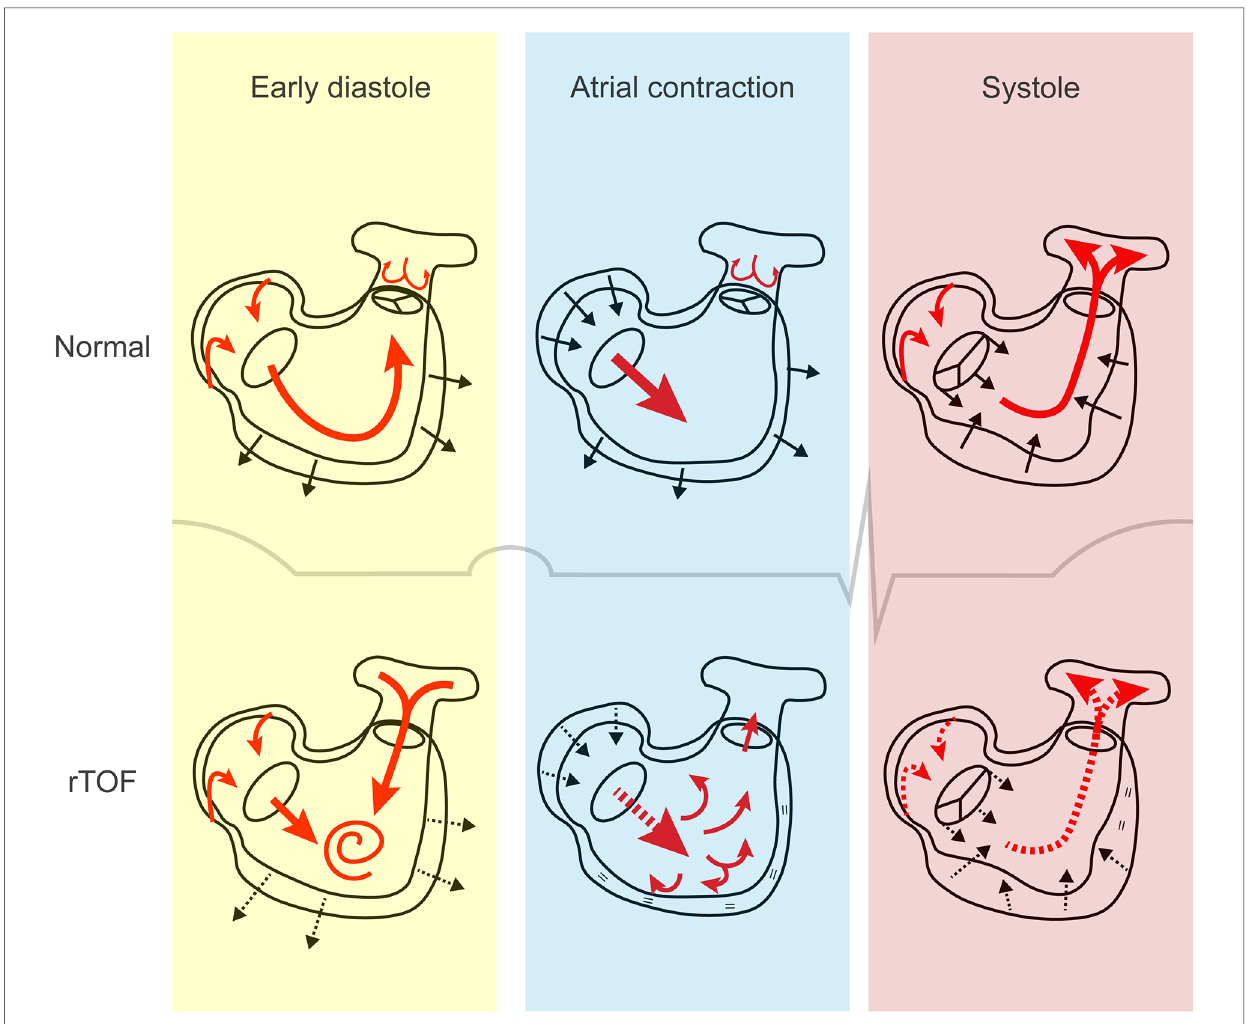
FIGURE 4 The cardiac cycle in tetralogy of Fallot. In early diastole, both right atrial conduit fl ow and pulmonary regurgitant fl ow contribute to right ventricular fi lling, resulting in increased fl ow vorticity. Decreased active relaxation and passive stiffness may be present. During atrial contraction, it is hypothesized that the stiff right ventricle may not be able to accommodate the additional blood volume, which gets displaced into the pulmonary artery. This phenomenon is referred to as end-diastolic forward fl ow. Right atrial contraction may be affected. In systole, decreased right ventricular contractility, dyssynchrony and out fl ow tract dysfunction can contribute to systolic dysfunction. Atrial reservoir fi lling is impaired if apical tricuspid movement is reduced. Red arrows, direction of blood fl ow; black arrows, movement of cardiac tissue (contraction or relaxation); dashed arrows, impaired fl ow or movement; equal sign, absent movement. rTOF, repaired tetralogy of